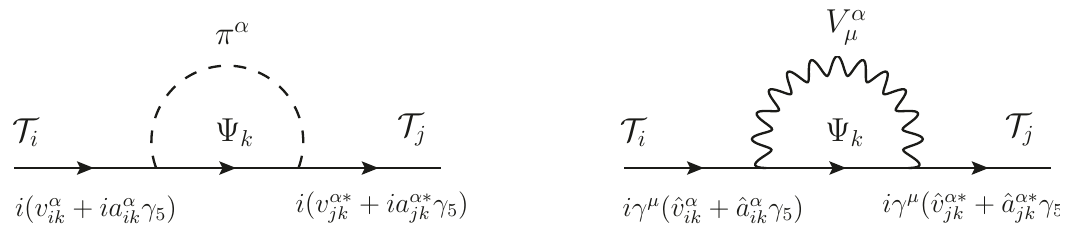
Figure 2 . The one loop diagrams contributing to the self energy of the top-partners in terms of generic dimensionless couplings v, a, ˆ v, ˆ a that can be expressed in terms of y L , y R , κ, M , and f for a spe- cific model. The expressions under the diagrams are the Feynman rules for the corresponding